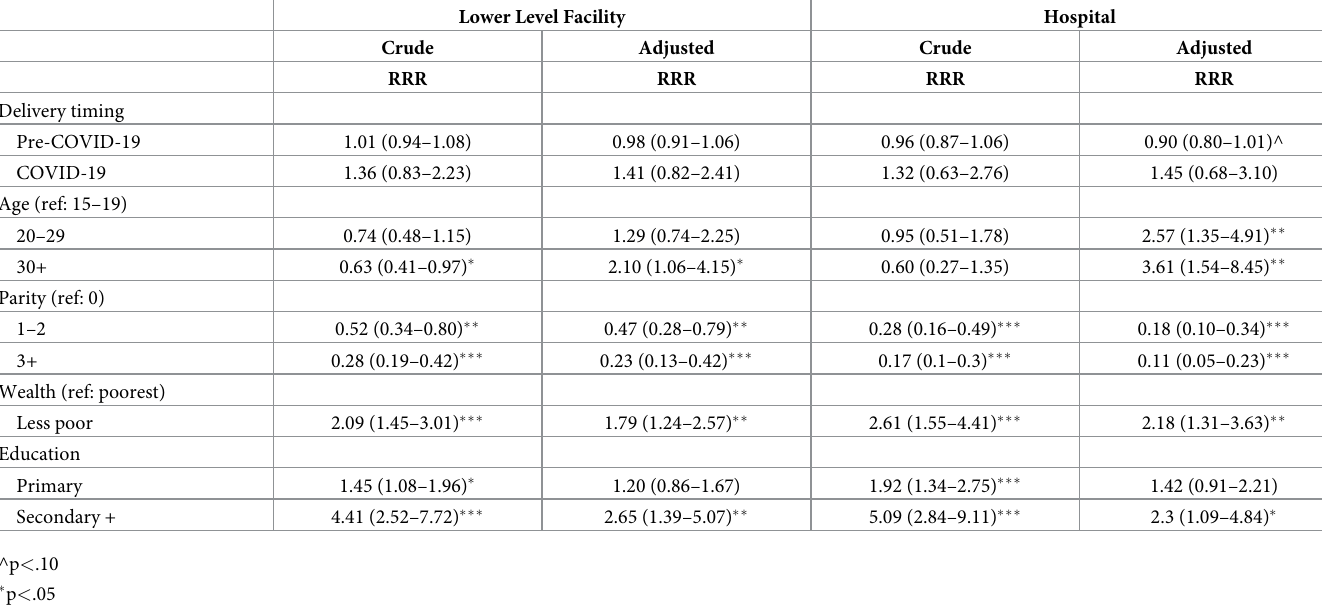
Table 4. Adjusted relative risk ratio of delivering in a lower-level health facility or government hospital relative to home delivery among women